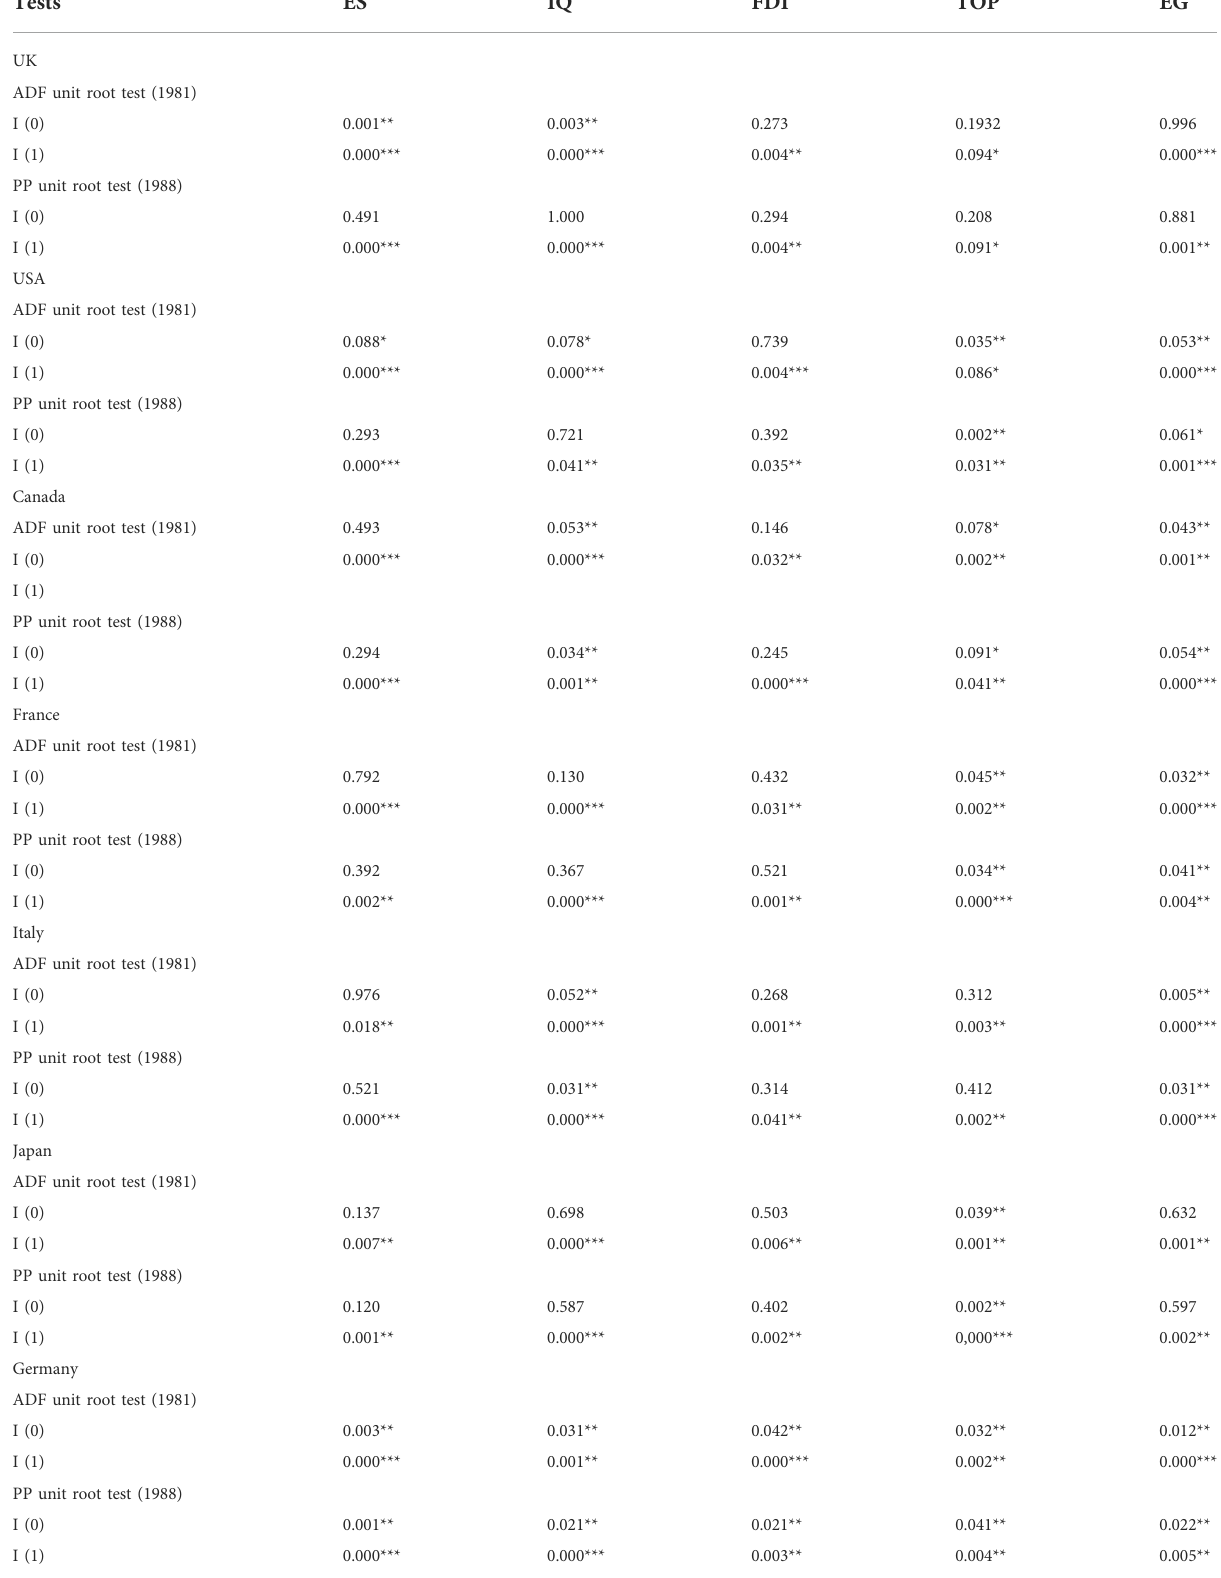
TABLE 3 Unit root